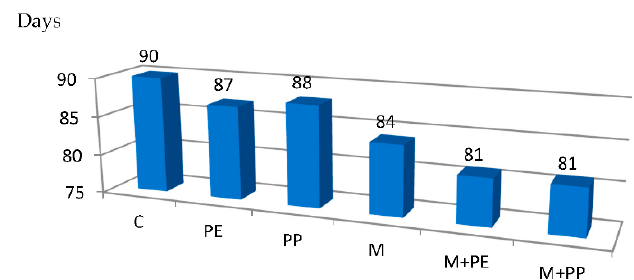
Figure 6. The effects of plant covers and soil mulching on the number of days between transplanting seedlings to the first harvest of tomatillo fruit) (means of 2015, 2017–2018) (means of 2015, 2017–2018). Explanation: C—control; PE—perforated PE film with 100 openings per m 2 for covering field beds (PE); PP—non-woven PP fabric with surface density of 17 g m − 2 for covering field beds; M—black PE film with a thickness of 0.05 mm for mulching; M + PE—black PE film with a thickness of 0.05 mm for mulching + perforated PE film with 100 openings per m 2 for covering field bed; M + PP—black PE film with a thickness of 0.05 mm for mulching + non-woven PP fabric with surface density of 17 g m − 2 for covering field